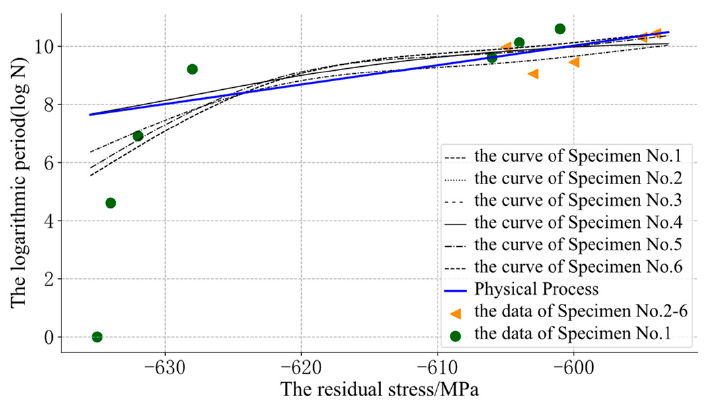
Figure 8. The assessment results of the GP-SS.